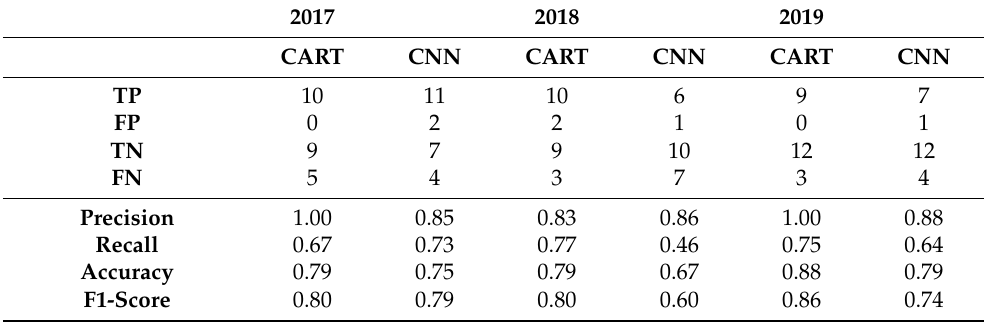
Table 1. Comparative performances between CART and CNN for temperature inversion